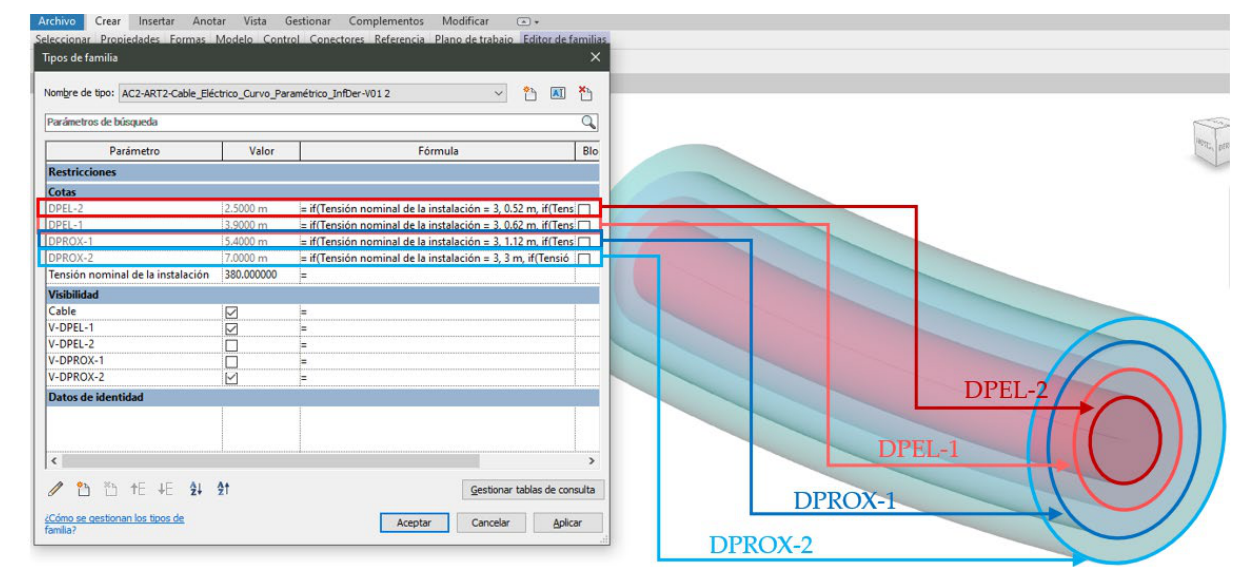
Figure 2. Creation of the parametric family of the electrical cable.